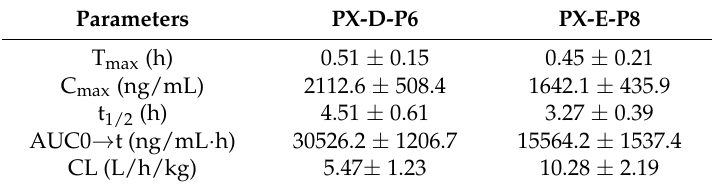
Table 2. The main pharmacokinetic parameters after i.p. administration of 50 mg/kg dose in rats ( n = 6).